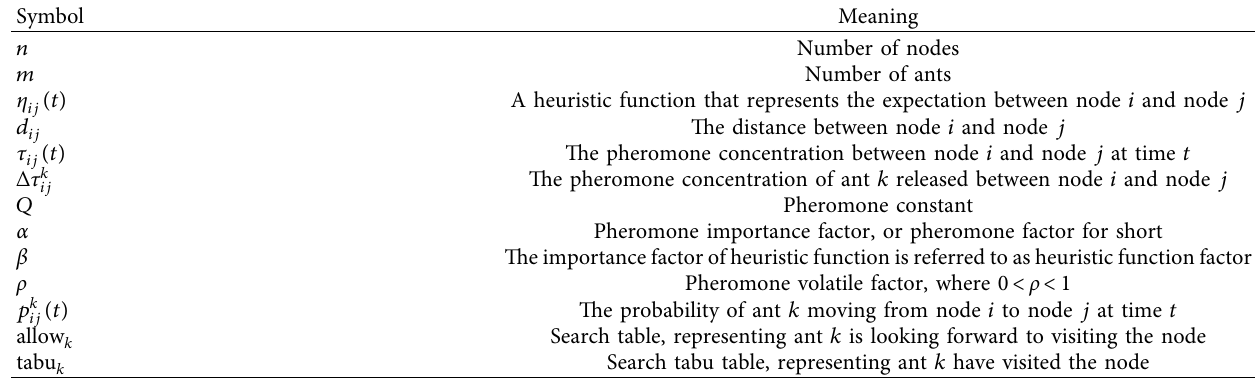
Search tabu table, representing ant k have visited the